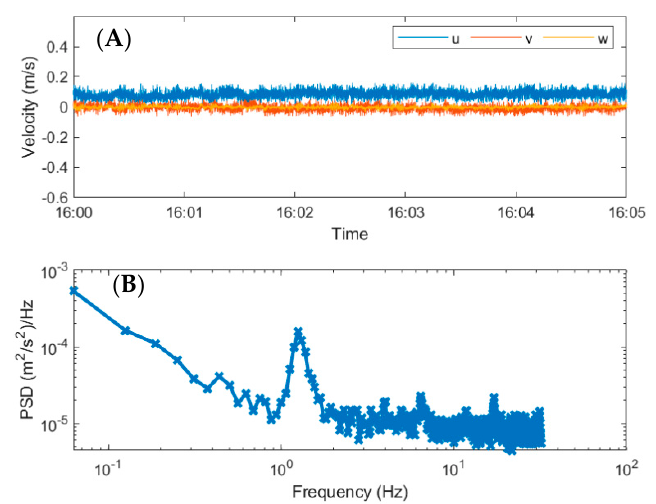
Figure 3. ( A ) sample time series of all three velocity components on 6 May 2018 beginning at 16:00, where the along-channel velocity ( u ) is blue, the across-channel velocity ( v ) is red, and the vertical velocity ( w ) is yellow; ( B ) power spectral density of along-channel velocity in ( A ), exhibiting a peak at a frequency within the approximate timescales for wind waves (~1 Hz). Such a record would be excluded from calculation of Reynolds shear stresses (see Section 3.3).